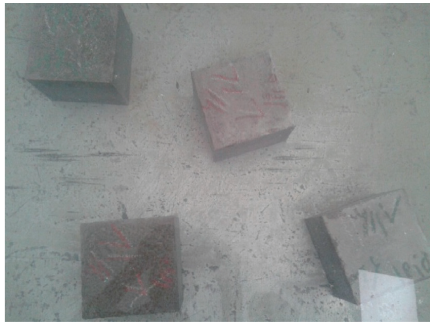
Figure 7: The soaked samples which are controlled by the digital temperature controller at 30 ° C for the first